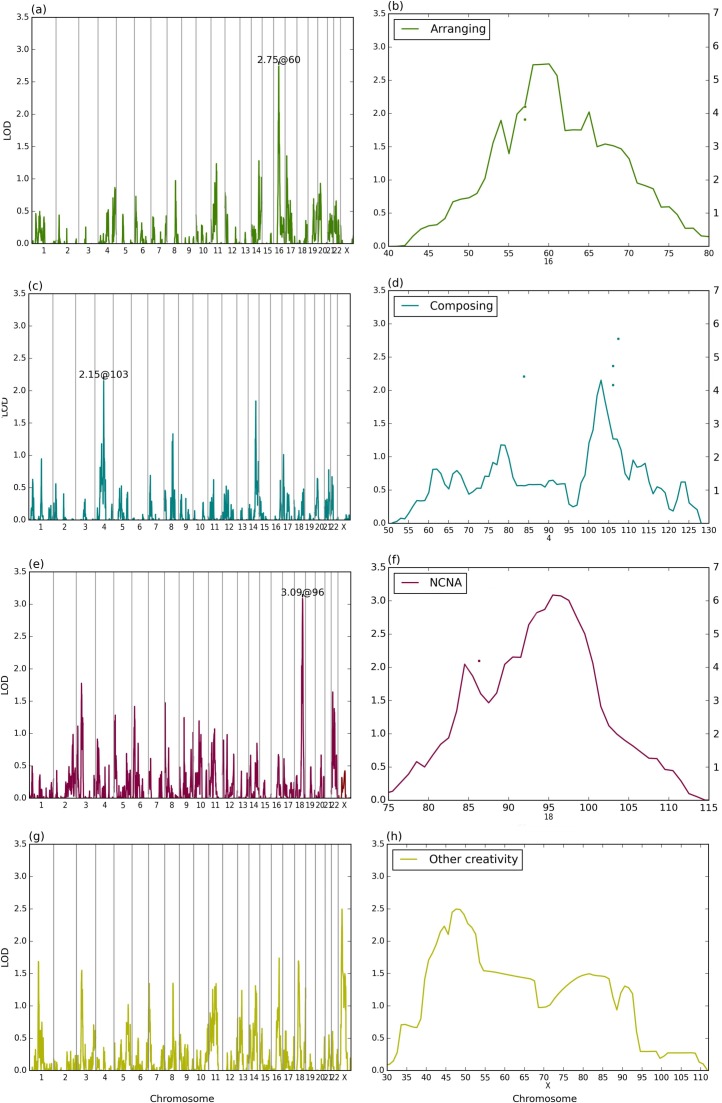
Merlin linkage results.Multipoint linkage LOD scores for arranging (a), composing (c) NCNA (e) and other creativity (g). The chromosomal region around the best LOD score is depicted for each phenotype (b, d, f and h for arranging, composing, NCNA and other creativity, respectively). On the best regions, multipoint linkages are illustrated by curves (scale on the left) and the best joint linkage and LD results by points as negative logarithmic values (scale on the right). The X-scale shows positions as centimorgans.